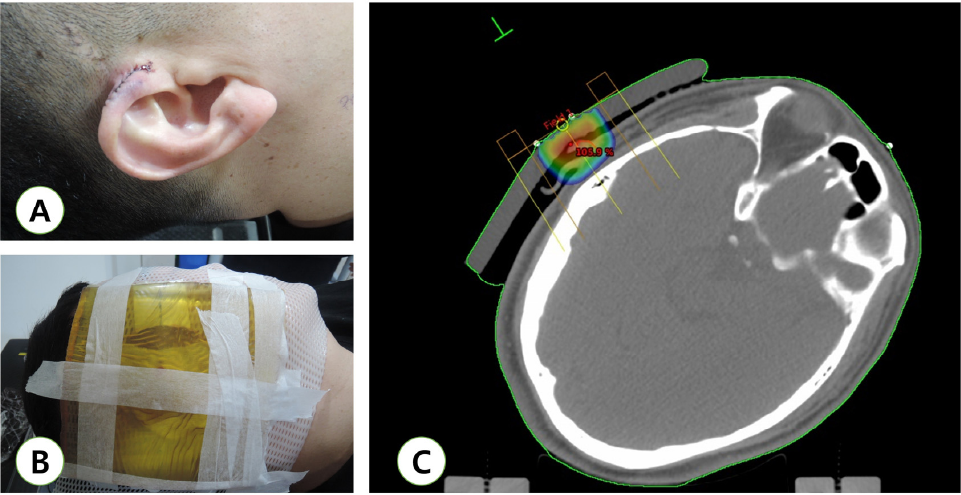
Figure 1. Example of computed tomography simulation for adjuvant radiotherapy using an electron beam. ( A ) Immediate post-operative view; ( B ) the patient was placed in a supine position and the head turned so that the ear to be treated was facing upward. A mask was used to immobilize the head. A part of the mask was excised to expose the area to be treated. A bolus was used to obtain a sufficient dose of the skin surface. The scar was marked with a wire. A margin of 1 cm around the scar was also marked with a wire to help with treatment planning; ( C ) computed tomography-based treatment plan for an ear keloid.